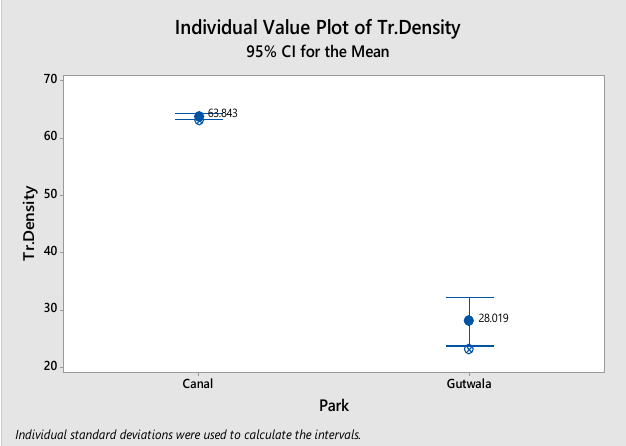
Individual Value Plot of Tr.Density 95% CI for the Mean